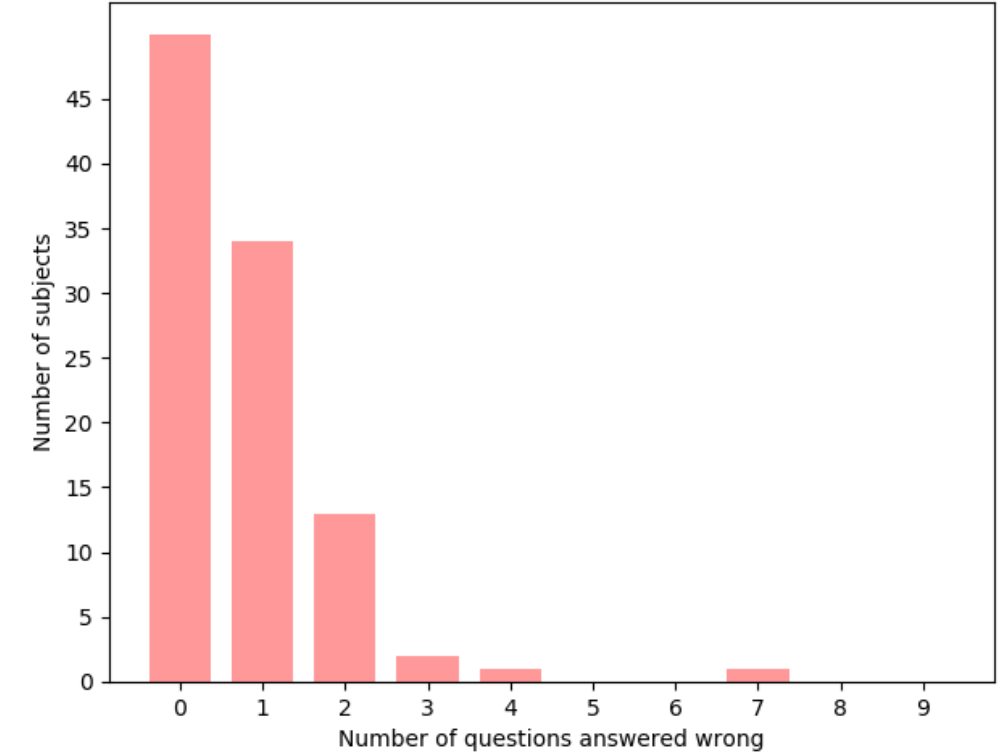
Figure 9. Histogram of the mistakes made by the